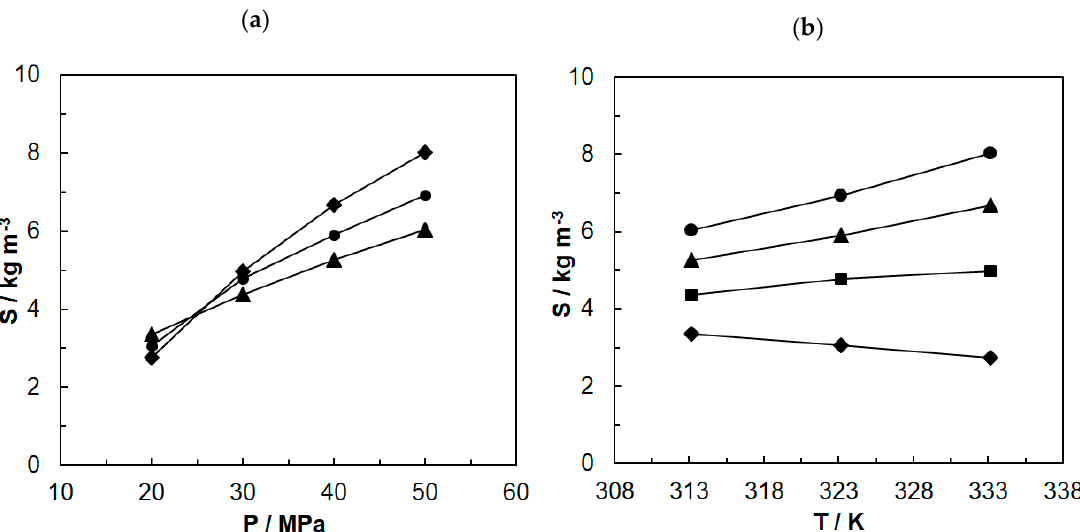
Figure 1. Solubility (S) of paprika extract in supercritical carbon dioxide: ( a ) solubility of extract at various temperatures depending on the pressure (( ▲ ) 313.15 K; ( ● ) 323.15 K; ( ♦ ) 333.15 K), ( b ) solubility of extract at various pressures depending on the temperature (( ♦ ) 20 MPa; ( ■ ) 30MPa; ( ▲ ) 40 MPa; ( ● ) 50 MPa).